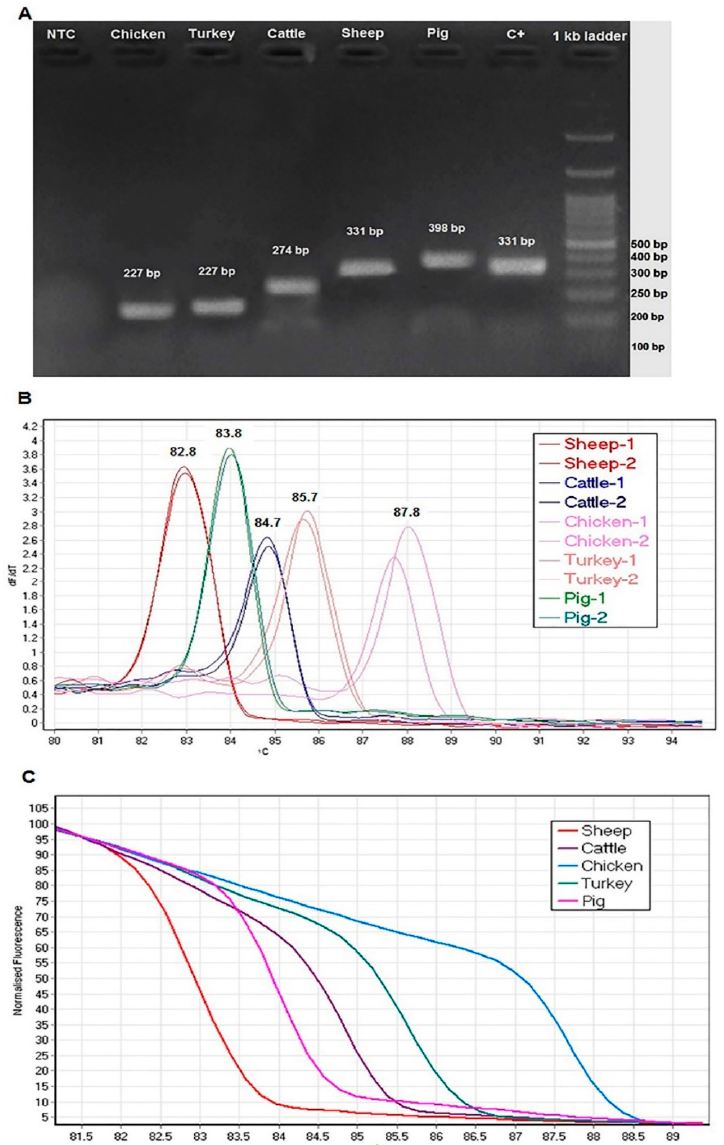
Figure 1. ( A ) PCR product length of amplified cytochrome b fragment specific for each meat